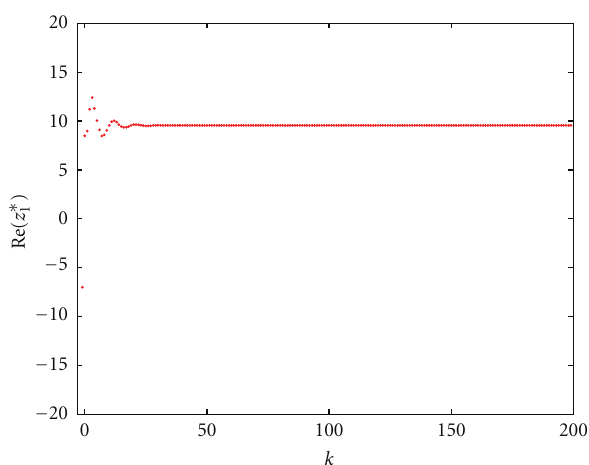
Figure 1: The behavior of the real part of z 1 (cid:5) k (cid:7) .